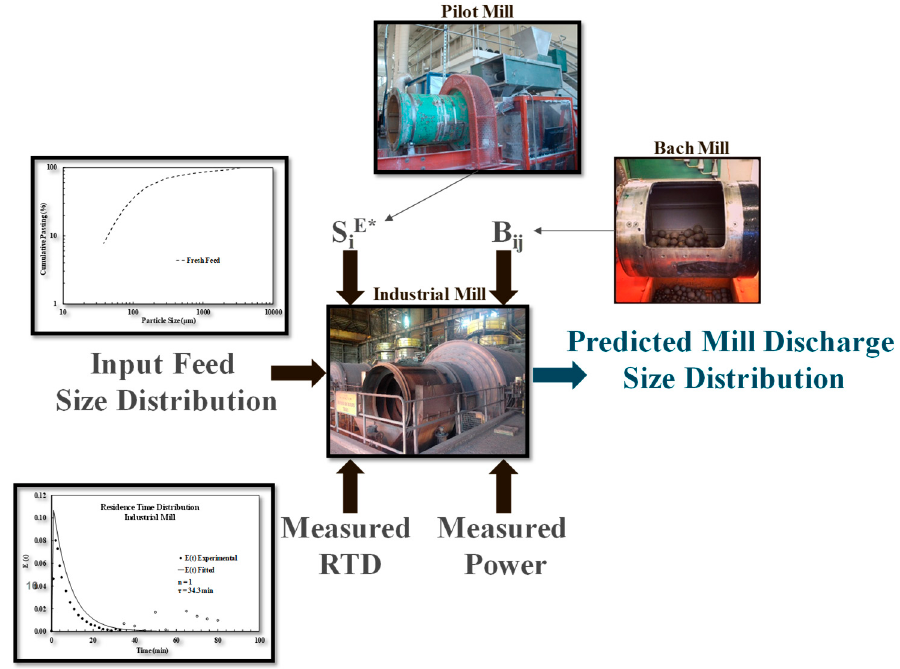
Figure 15. Prediction methodology scheme for the industrial scale mill.